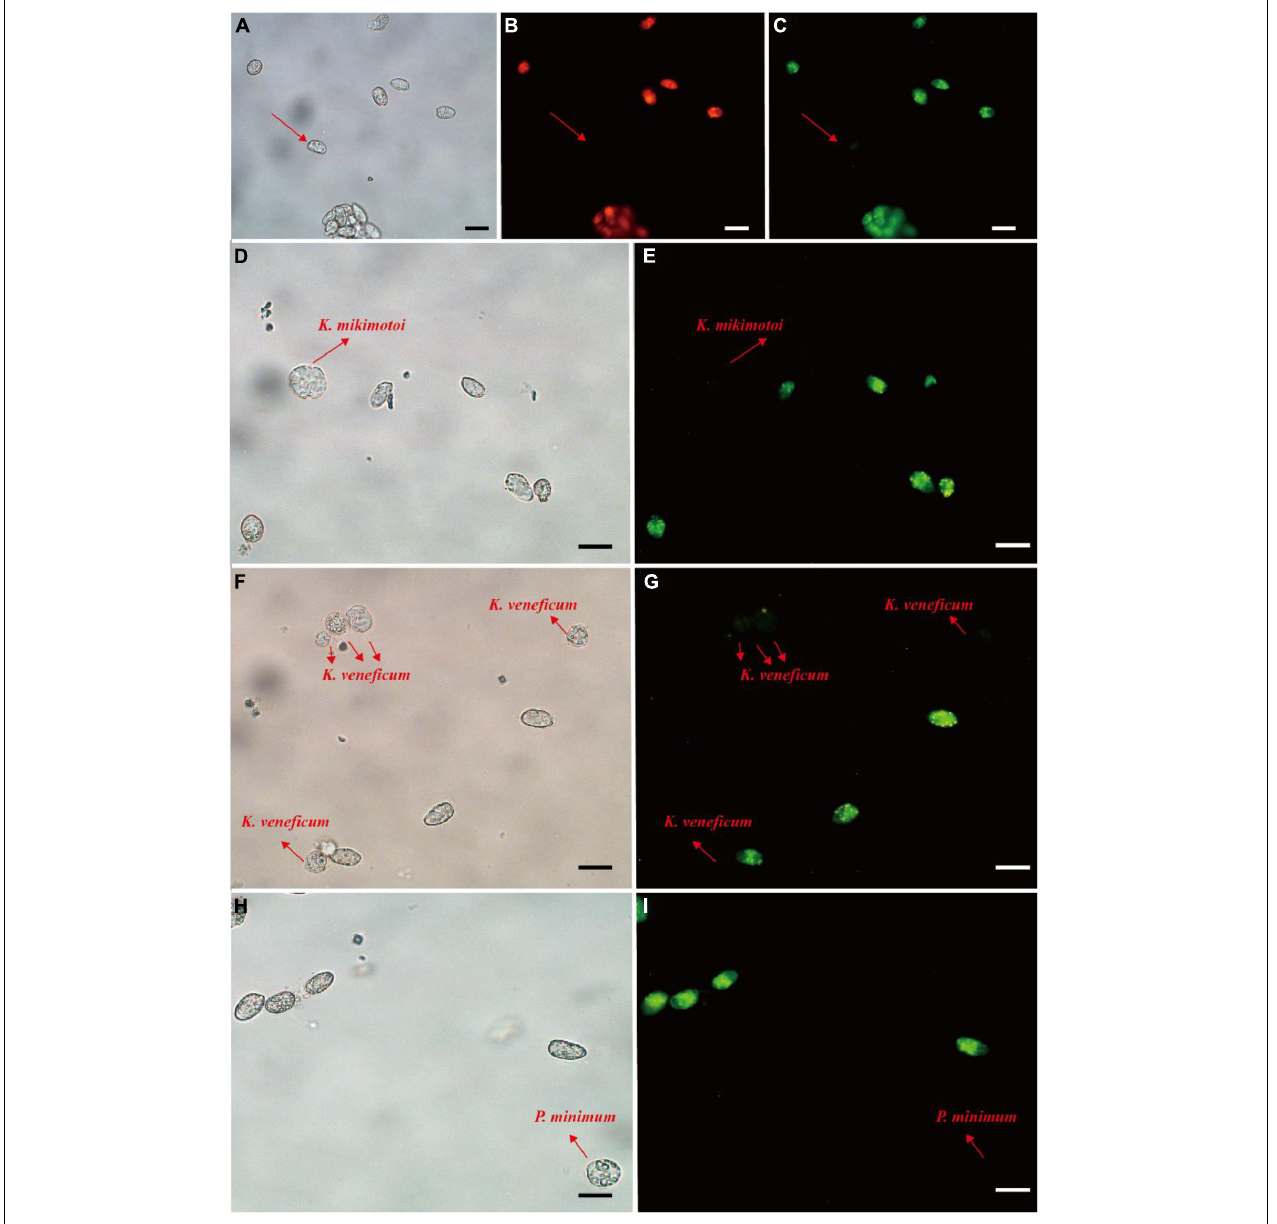
FIGURE 4 | Prorocentrum donghaiense vegetative cell labeled with two fluorescence signal probes (Cy3 and FITC). Cells were observed at bright field LM, orange epifluorescent LM for Cy3-labeled cells and green epifluorescent LM for FITC-labeled cells (A–C) . Specificity tests for the PDprobe-8 using mixed samples (D–I) , containing P. donghaiense and K. mikimotoi , P. donghaiense and K. veneficum , P. donghaiense and P. minimum , respectively. The arrows indicated the cells were not labeled with probe. Scale bars = 20 µ